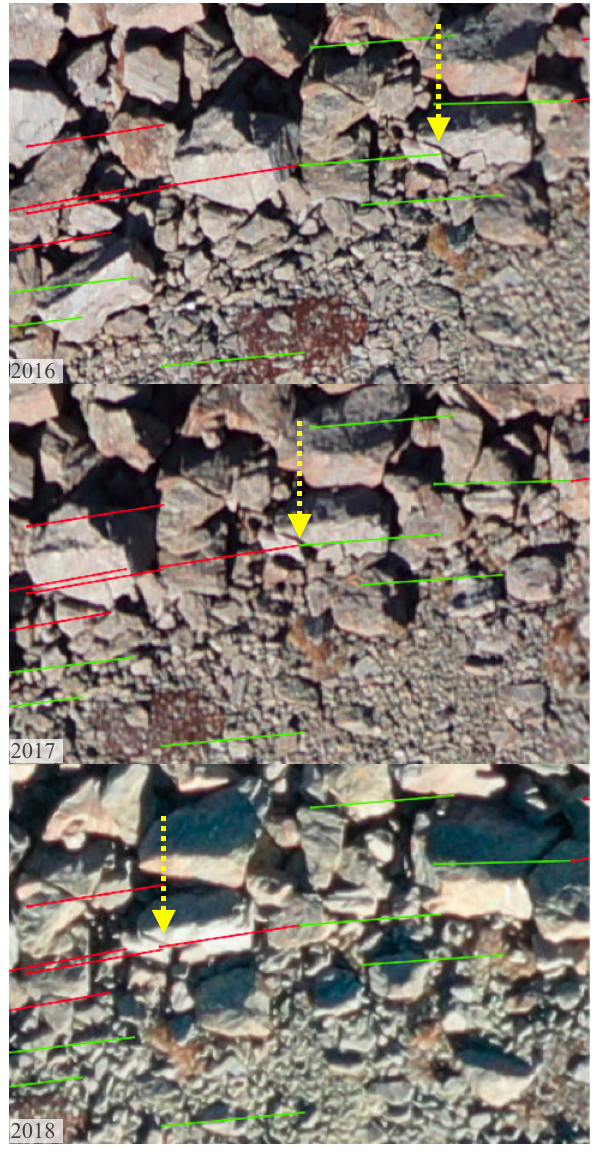
Figure 5. Tie point matching detail 2016, 2017 and 2018 green: 2016-2017 red: 2017-2018